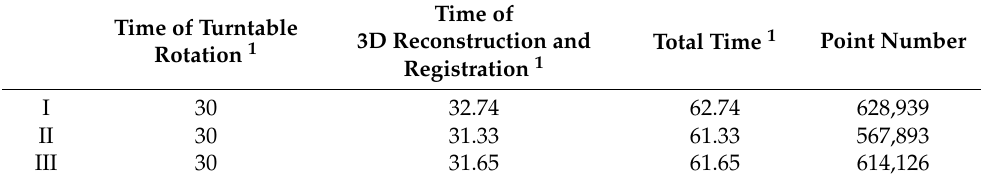
Table 3. Statistics for scanning time